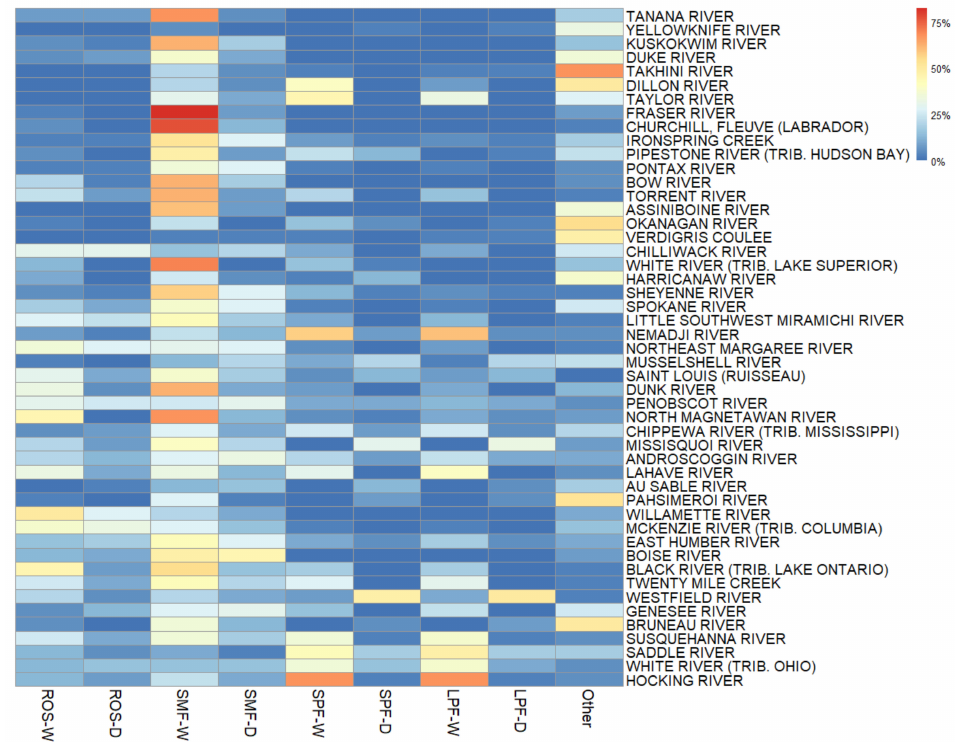
Figure 6. Heatmap for the North American catchment distribution of annual maximum (AM) flood typologies. Catchments are sorted from the south to the north.